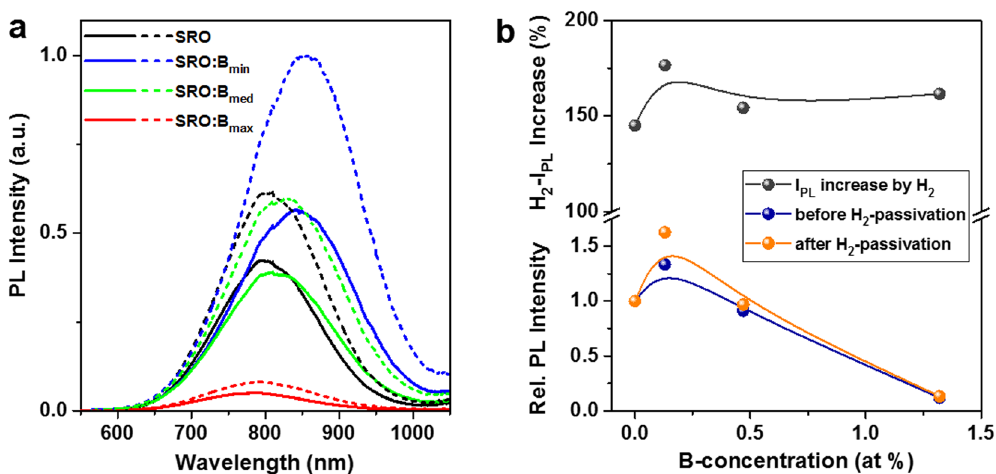
Figure 3. Photoluminescence of B-incorporating Si NCs. ( a ) PL spectra of NC samples before (solid lines) and after (dashed lines) H 2 -passivation with nominal B-concentrations of: [B min ] = 0.13 at%, [B med ] = 0.47 at%, and [B max ] = 1.32 at%. While all samples have similar peak positions, the highest B-concentration leads to a strong luminescence quenching by one order of magnitude. ( b ) The PL peak analysis demonstrates the small PL-intensity gain by 0.13 at% B, irrespective of H 2 -passivation and similar intensities of the 0.47 at% samples compared to the undoped references. The H 2 -passivation increases the PL-intensity on average by ~60%. All lines (splines) are just a guide to the